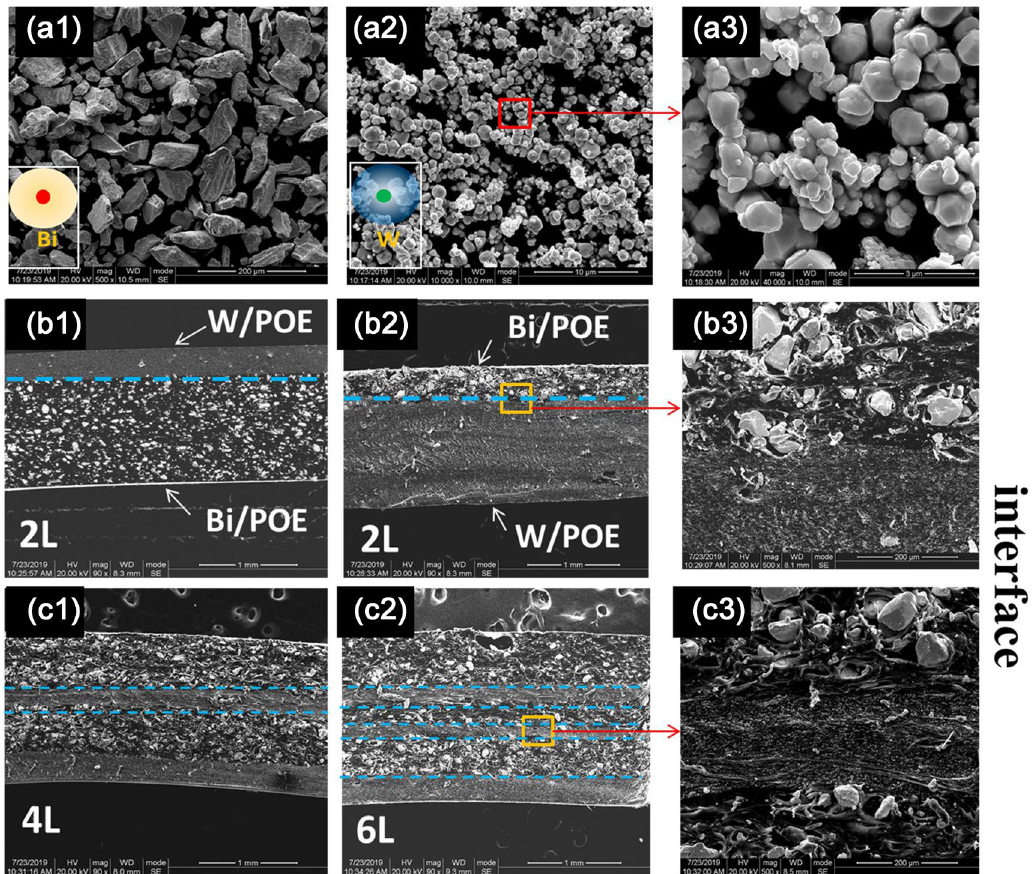
Figure 4. Scanning electron microscope (SEM) of bismuth ( a1 ) and tungsten ( a2 ) powders, and the local magnification image of the tungsten powders ( a3 ); the (Bi/POE)/ (W/POE) layered composites ( b1 ), and the layer thickness ratio was 7:3; the (W/POE)/(Bi/POE)layered composites ( b2 ), and the layer thickness ratio also was 7:3; the cross section of alternating layered composites with 4 and 6 layers were shown in Figure ( c1 ) and ( c2 );moreover, a local enlargement of the layered interface was shown in Figure ( b3 ) and ( c3